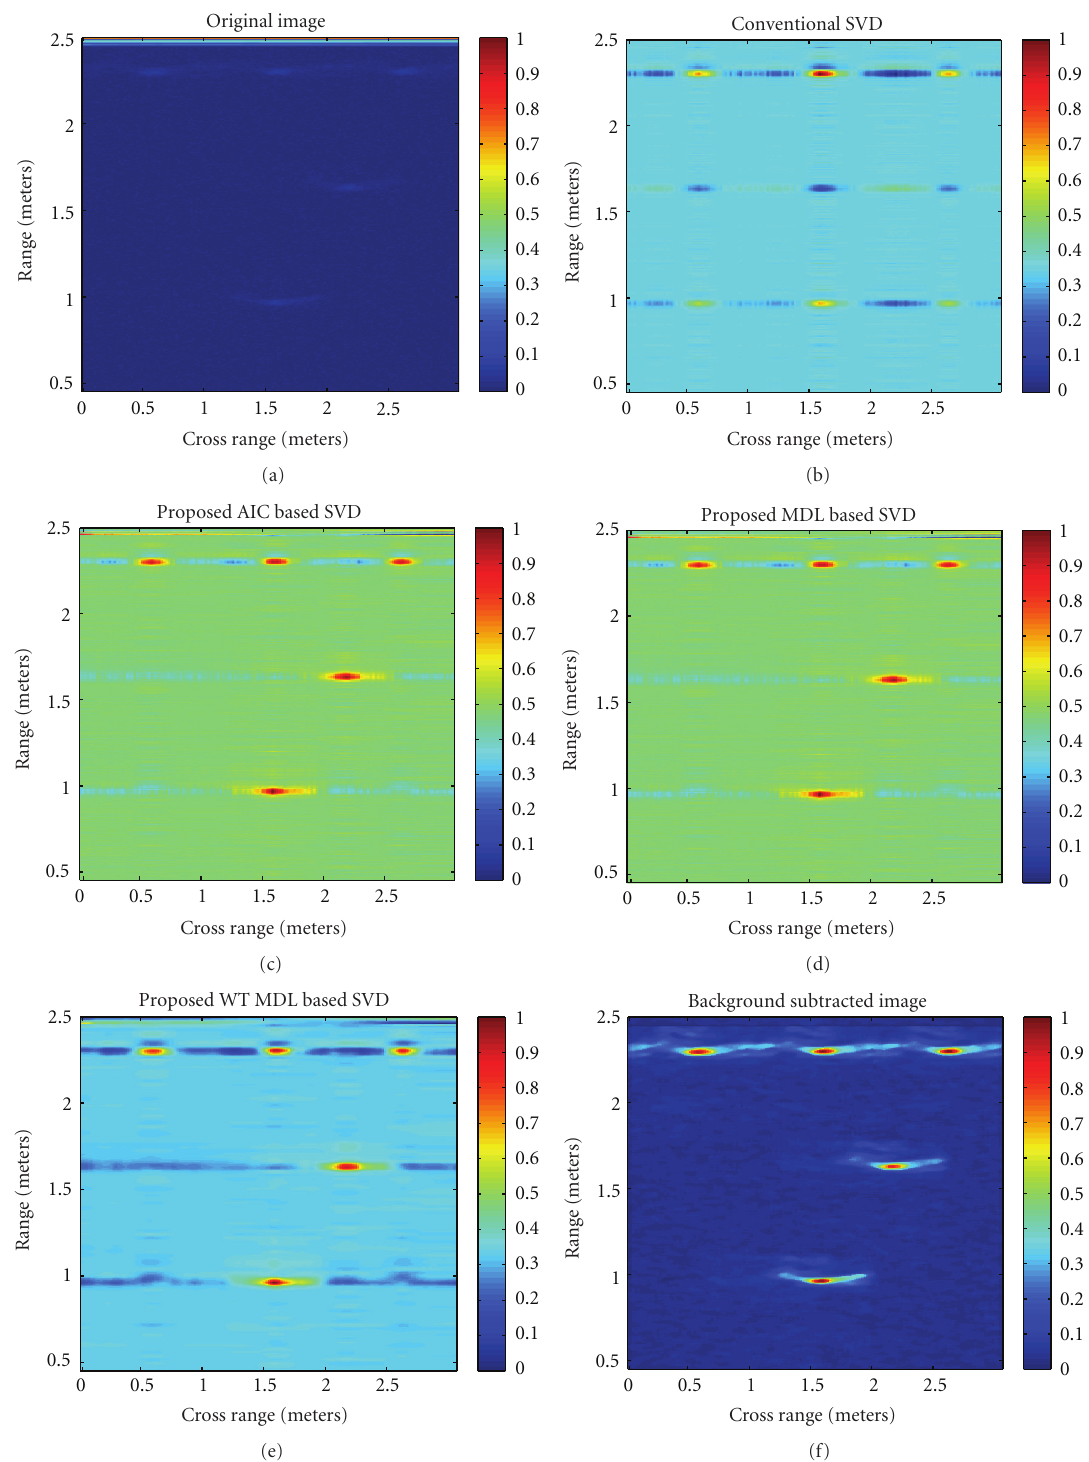
Figure 18: Example 4: Multiple (five) targets (a) original image, (b) conventional SVD, (c) AIC-based SVD, (d) MDL-based SVD, (e) WT MDL-based SVD, and (f) background subtracted